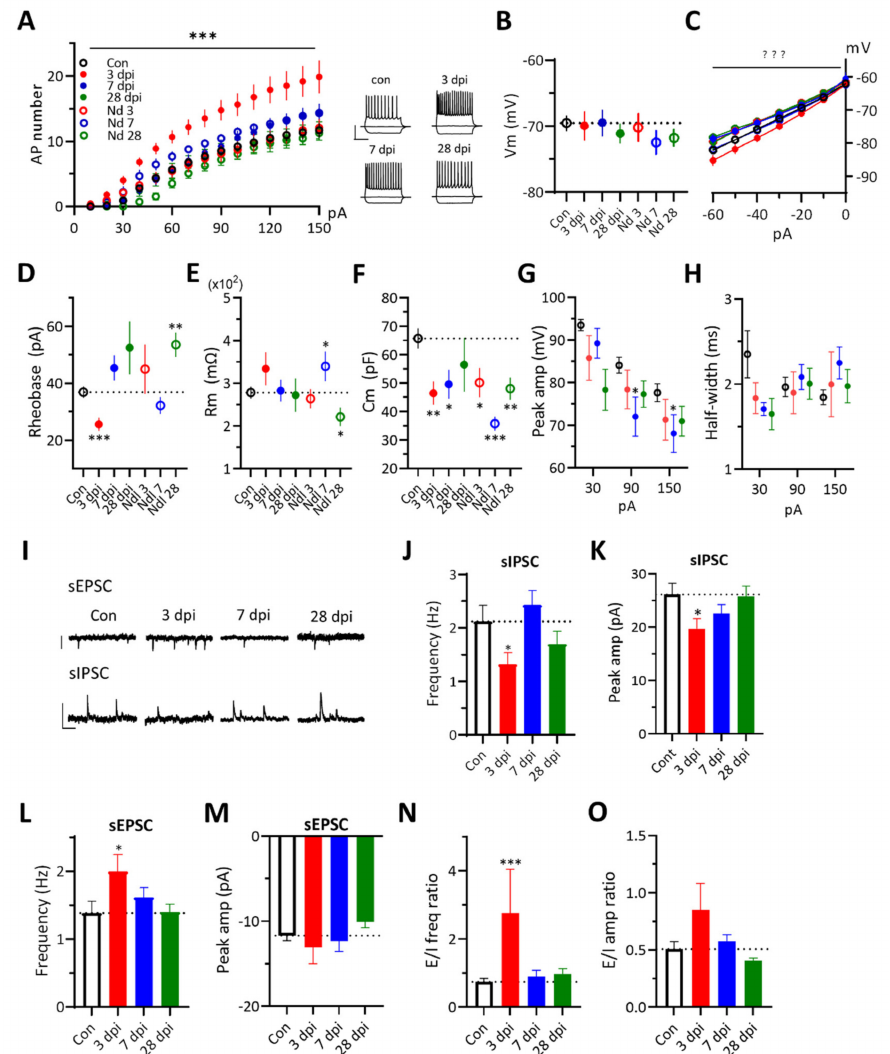
Figure 3. Changes of neuronal excitability and synaptic transmission properties for a month period after ATP injection. Two-way ANOVA with Tukey’s test or two-tailed t -test for comparing the experimental group to the control group (*, p < 0.05; **, p < 0.01; ***, p < 0.001). ( A ). The number of action potential firings in neurons at the indicated dpi to 500 msec depolarization pulses compared with needle-controls. Two-way ANOVA with Tukey’s test. Insets , Example traces of cortical neuron firing to − 60, 0, +120 pA current injections. The same color and symbol of each condition are used from A to H below. ( B ). Resting membrane potential measurements. Two-tailed t -test. ( C ). I–V plot of neurons to hyperpolarizing current steps. Two-way ANOVA with Tukey’s test. ( D ). Rheobase measurements. Two-tailed t -test. ( E ). Membrane resistance measurements. Two-tailed t -test. ( F ). Membrane capacitance measurements. Two-tailed t -test. ( G , H ). Measurements of the peak amplitude and the half-width of 1st action potential spike generated at +30, +90 and +150 pA injections. Two-tailed t -test. ( I ). Example traces of sEPSCs recorded at − 70 mV and sIPSC recorded at +10 mV of holding potentials in control and ATP injected groups. Scale bars , 20 pA (sEPSC), 50 pA (sIPSC), 200 ms. ( J , K ). The frequency and peak amplitude of sIPSCs. Two-tailed t -test. ( L , M ). The frequency and the peak amplitude of sEPSCs. Two-tailed t -test. ( N ). The frequency ratio of sEPSC over sIPSC. Two-tailed t -test. ( O ). The amplitude ratio of sEPSC over sIPSC. Two-tailed t